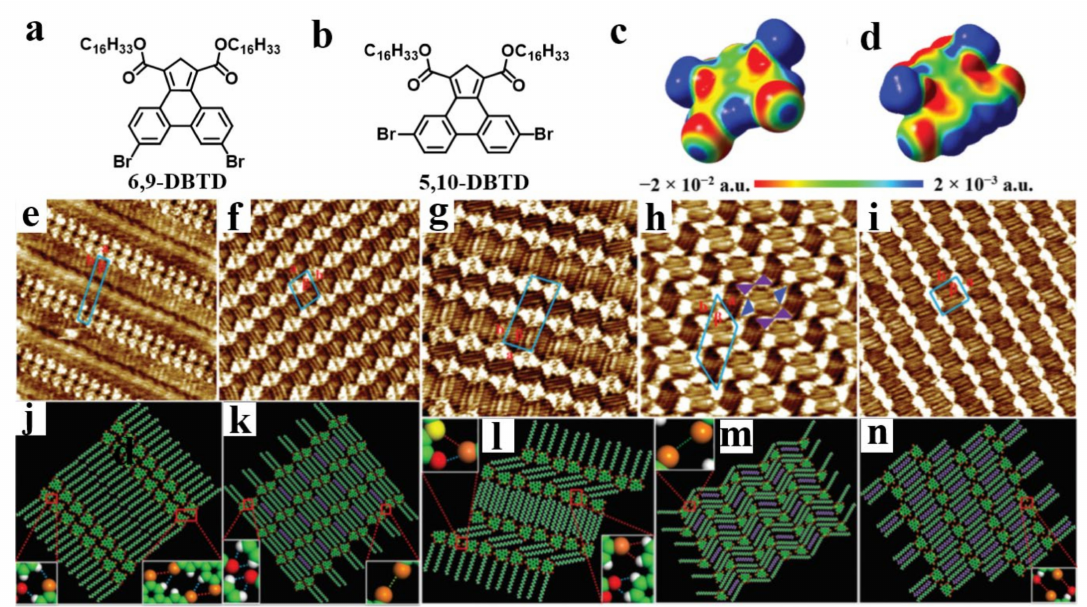
Figure 14. ( a – d ) Chemical structures of 6,9-DBTD and 5,10-DBTD and their calculated 3D ESP maps. ( e , f ) High-resolution STM images show the lamellar structure (1.2 × 10 − 4 M) and co-adsorbed linear pattern (6.2 × 10 − 5 M) of 6,9-DBTD adlayers at the n- tridecane / HOPG interface. ( g – i ) High-resolution STM images showing vertebra-like structure (2.8 × 10 − 4 M), hexagonal network pattern (5.7 × 10 − 5 M), and linear pattern (5.3 × 10 − 6 M)) of 5,10-DBTD adlayers at the n- tridecane / HOPG interface. Image area: ( e – g , i ) 20 × 20 nm 2 , ( h ) 17 × 17 nm 2 . ( j – n ) Proposed structural models of ( e – i ).